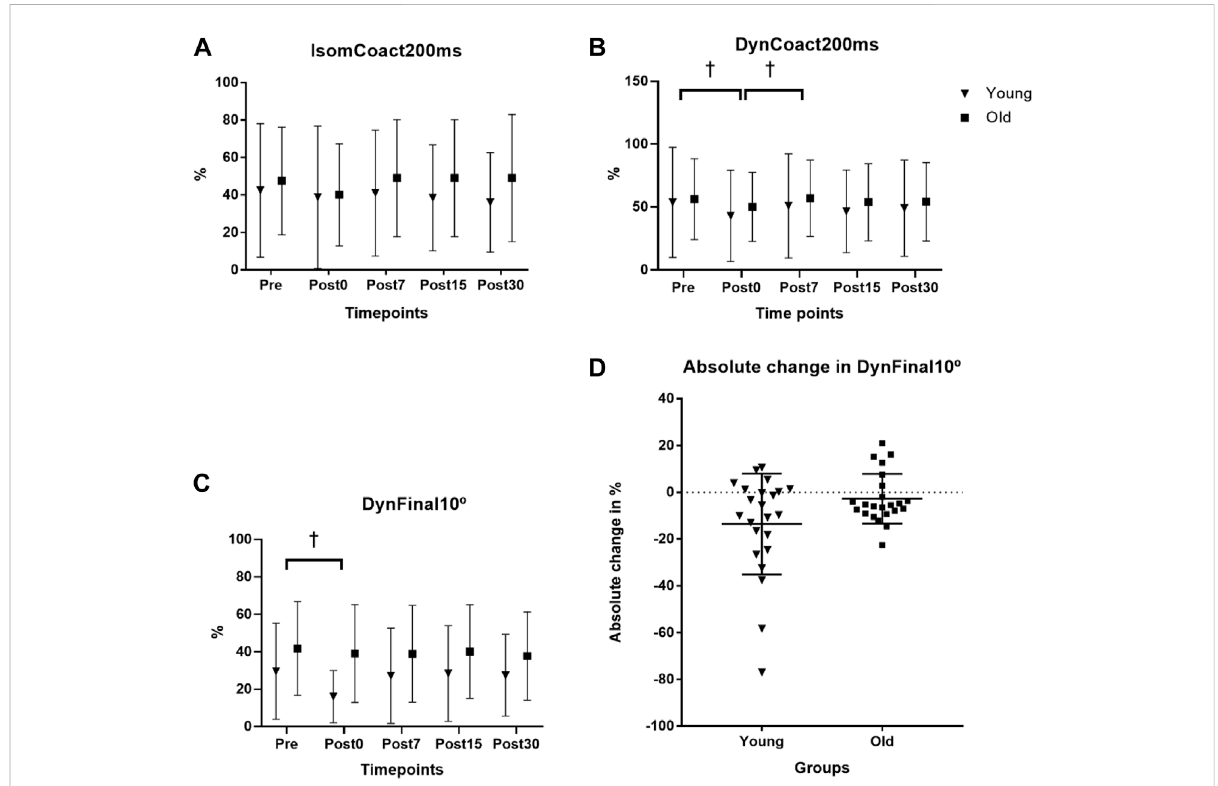
FIGURE 1 Effects of age and fatigue on antagonist muscle coactivation. (A) The isometric biceps femoris (BF) antagonist muscle coactivation RMS at 0 – 200 ms (IsomCoact200ms) variable had no interaction ( p = 0.237) nor main effect for time ( p = 0.277). (B) The dynamic isokinetic 240 ° · s − 1 BF coactivation RMS at 0 – 200 ms (DynCoact200ms) variable had no interaction ( p = 0.802), but there was a main effect for time ( p = 0.018). Follow up analyses with collapsed groups showed that Pre was higher than Post0 ( p = 0.009), and Post7 was higher than Post0 ( p = 0.011, depicted by † ). (C) BF coactivation for the fi nal 10 ° of the leg extension range of motion (DynCoact10 ° ) for the isokinetic 240 ° · s − 1 MVCs showed no interaction ( p = 0.070),but therewasamain effectfor time ( p =0.020).Follow upanalyses with collapsed groupsshowed thatPre washigher thanPost0 ( p = 0.022, depicted by † ). Data for (A – C) , represent mean ± SD. (D) A univariate scatterplot depicts the absolute change in sEMG RMS for the DynCoact10 ° variablefrombefore(Pre)toimmediatelyafter (Post0) thefatigue protocolfortheyoung andoldgroups.Horizontal barsrepresentthegroupmeans (young = − 13.59% ± 21.54%; old = − 2.72% ±